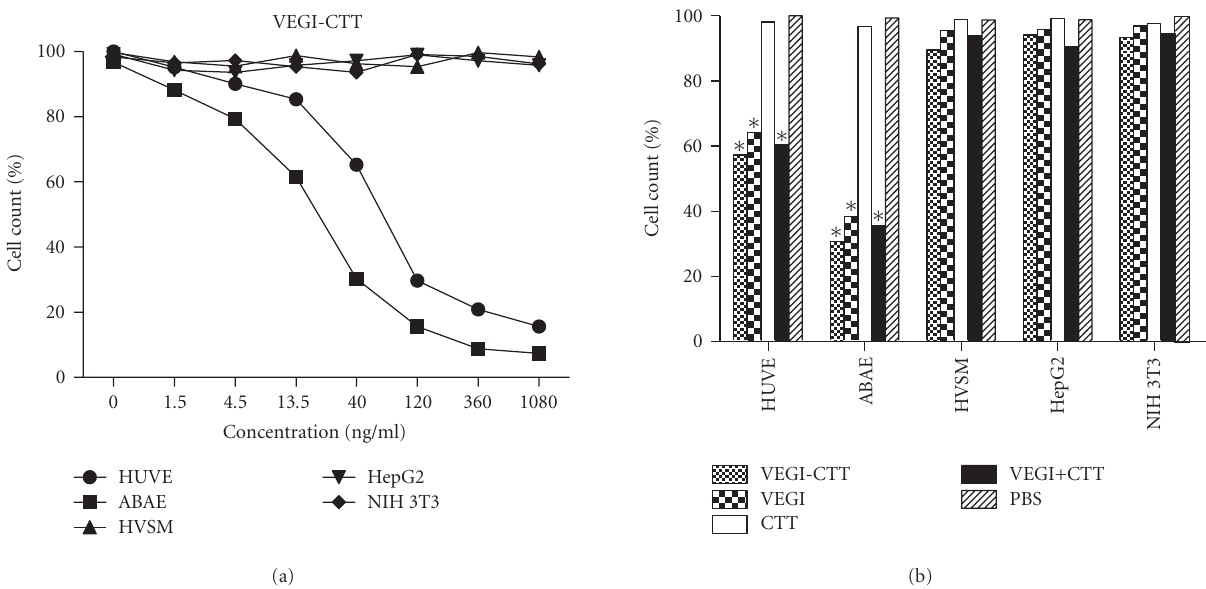
Figure 5: Specific inhibition of endothelial cell proliferation by chimeric protein VEGI-CTT. Cells were seeded in triplicate at 3000–5000 cells/well in 96-well plates. Culture conditions are described in Section 2. The media were changed once on day 3. The number of viable cells was determined on day 6 by using a Coulter counter. Mean values are presented as a function of VEGI-CTT or other agents’ concentrations. ∗ P < . 05 versus that of PBS group.